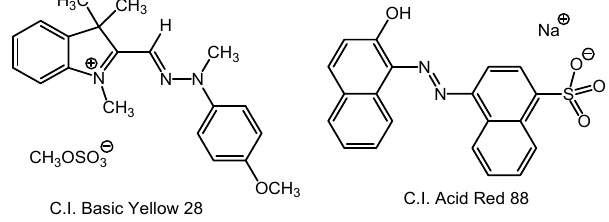
Figure 1. Molecular structure of the printed dyestuffs.